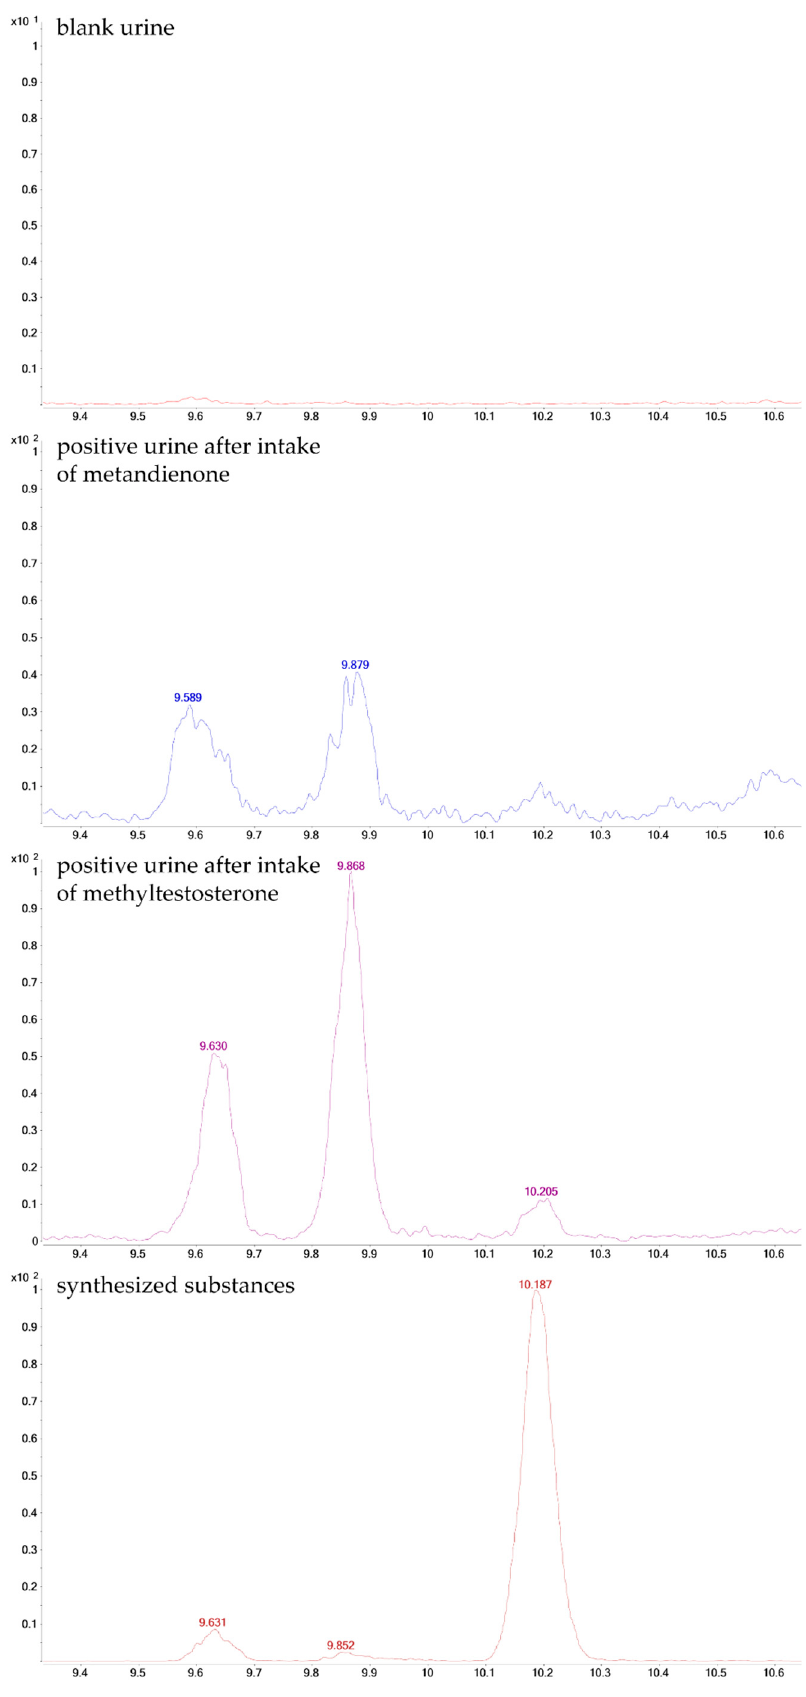
Figure 8. GC-QQQ-MS chromatograms (MRM, m / z 345 173 ).